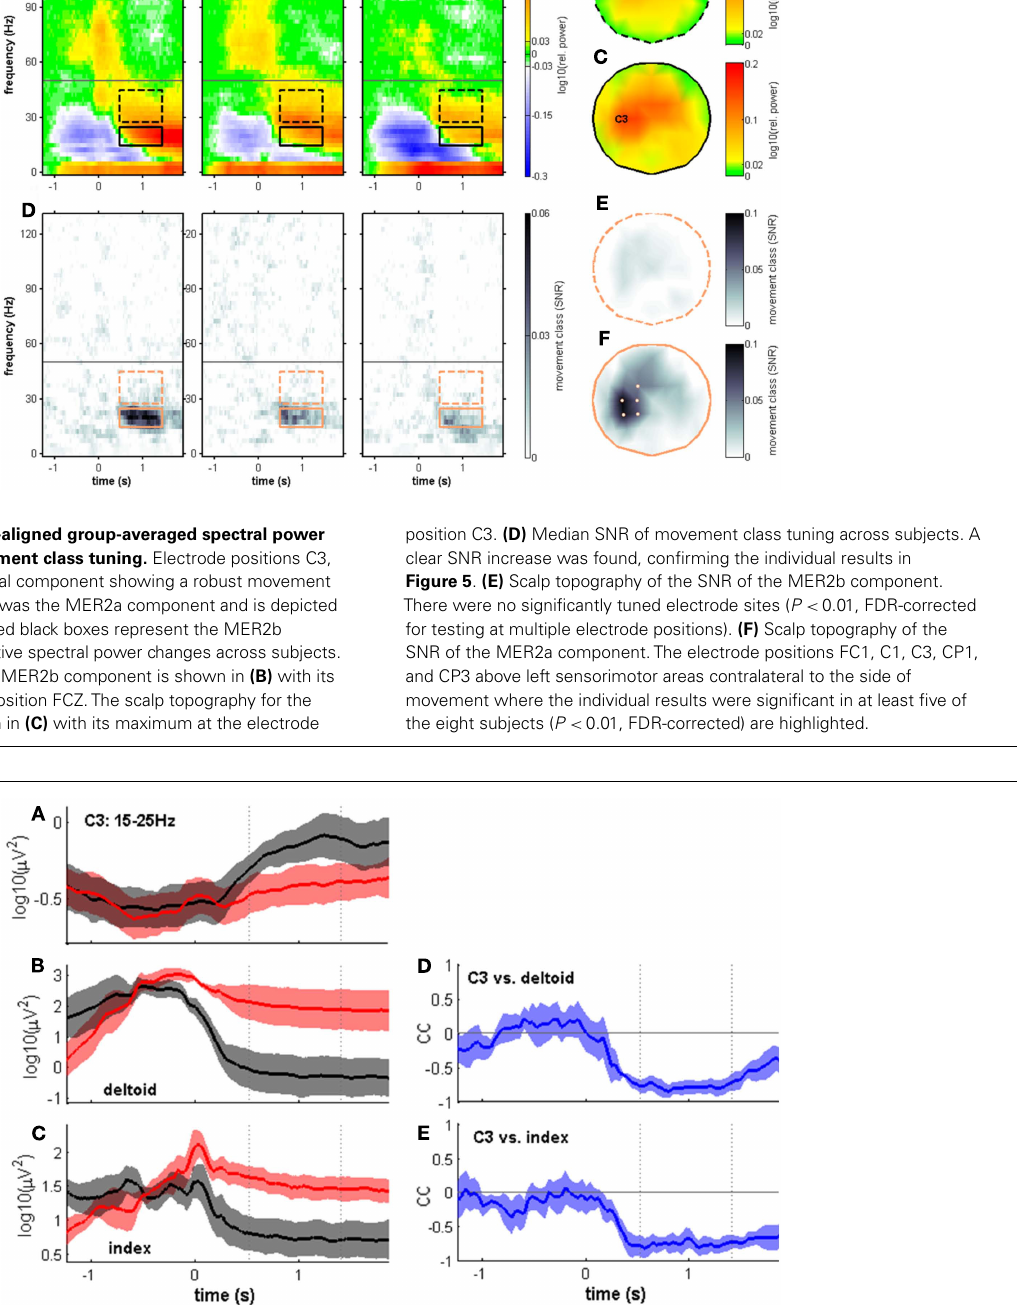
class for which the modulation was most pronounced. (A) Time course of the MER2a component at electrode position C3. (B,C) Same as (A) but for EMG of the contralateral deltoid (B) and flexor indicis (C) muscles. In both cases, EMG levels were higher after the center-out than after the center-in movement. (D,E) Signal correlations (correlation coefficients (cc) on the y axis) between the MER2a component and deltoid EMG (D) and flexor indicis EMG (E) using the trial-averaged activities of all movement classes (see Table 3